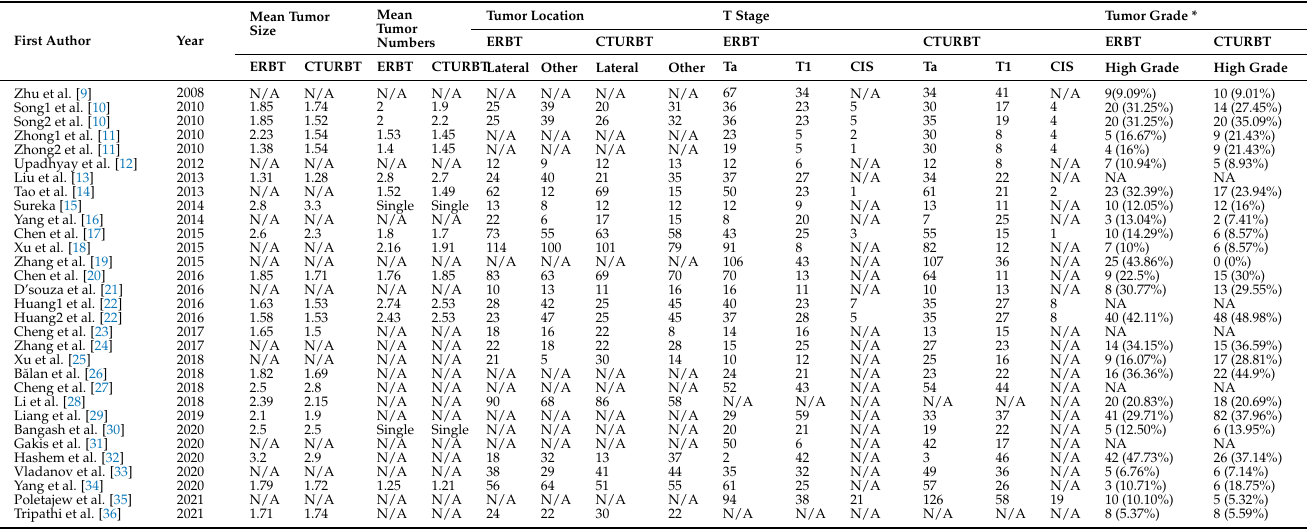
Table 2. The tumor characteristics of studies included in this article. RCT, randomized controlled trial; Single, studies only enrolled the patients with single tumor; Ta noninvasive tumor; CIS, carcinoma in situ; N/A, not available. * The table shows the number of high-grade tumors, with the parentheses indicating the percentage of high-grade tumors among all